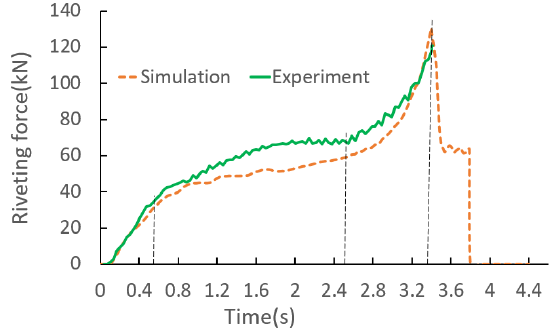
Figure 11. Vertical riveting force in the process of riveting assembly.